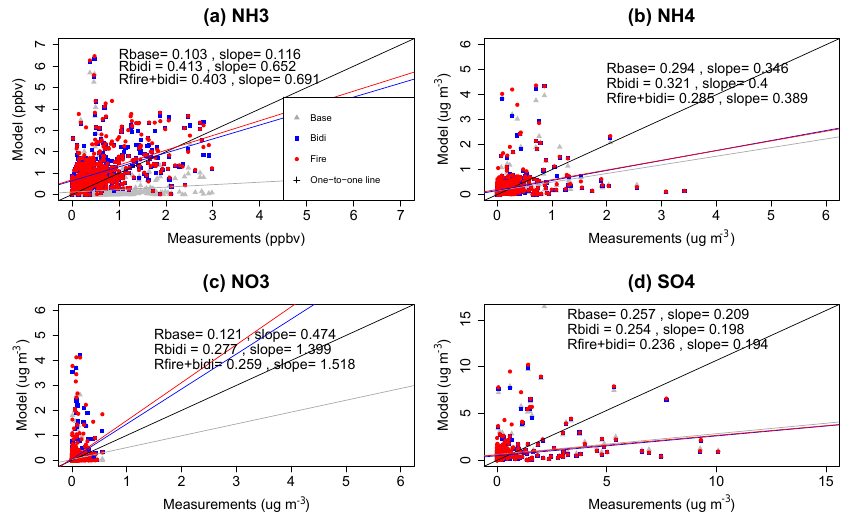
Figure 6. Hourly modelled vs. measured surface (a) NH 3 VMR, and (b) NH + site in the AOSR. Base model is in grey, bidirectional flux model in blue, and fire + bidi model in